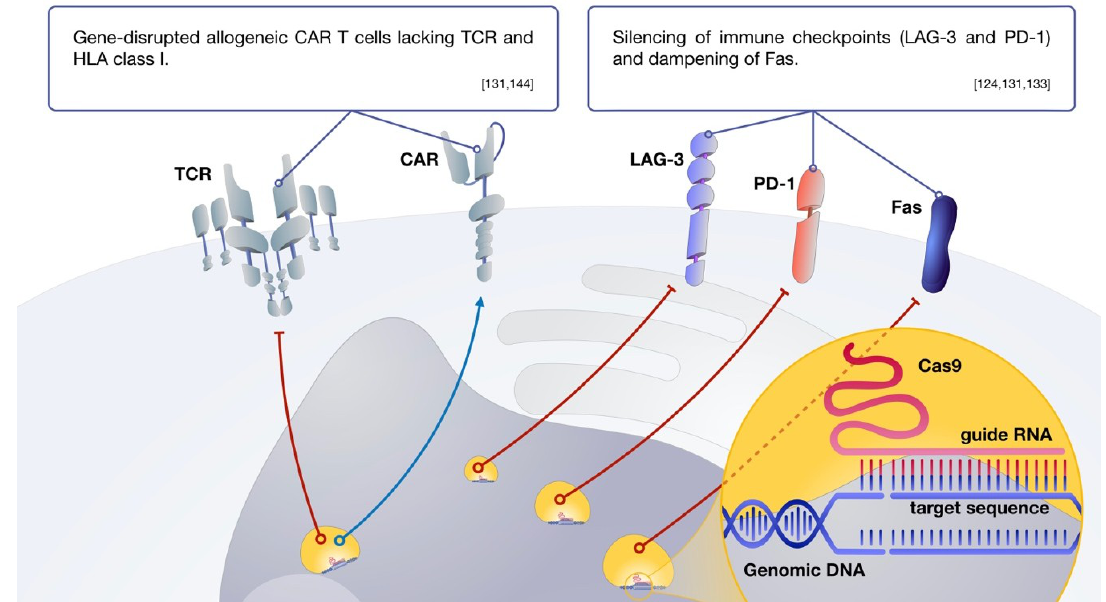
Figure 4. CRISPR-based approaches for the genetic modification of CAR T cells. Gene disruption approaches have been shown to be effective for the silencing of inhibitory axis, and the development of universal CAR T cells. Red solid and dotted lines depict silencing or disruption of genes. Blue line depicts insertion of CAR.